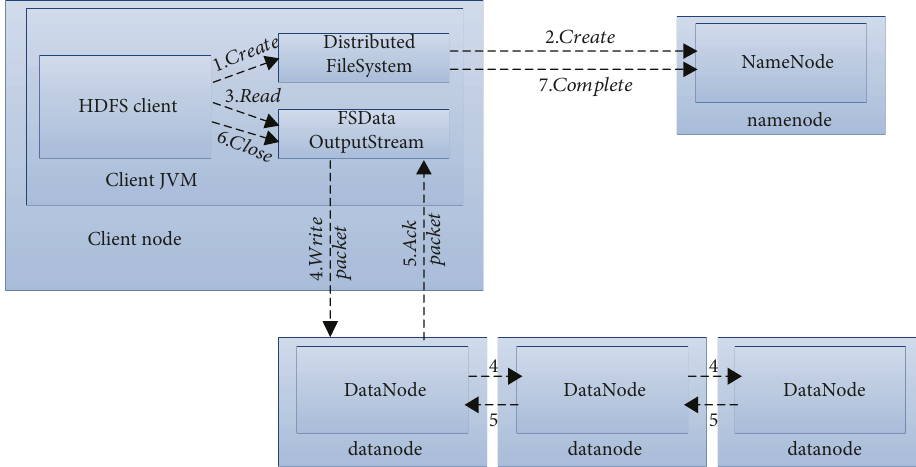
Figure 5: Write fl ow